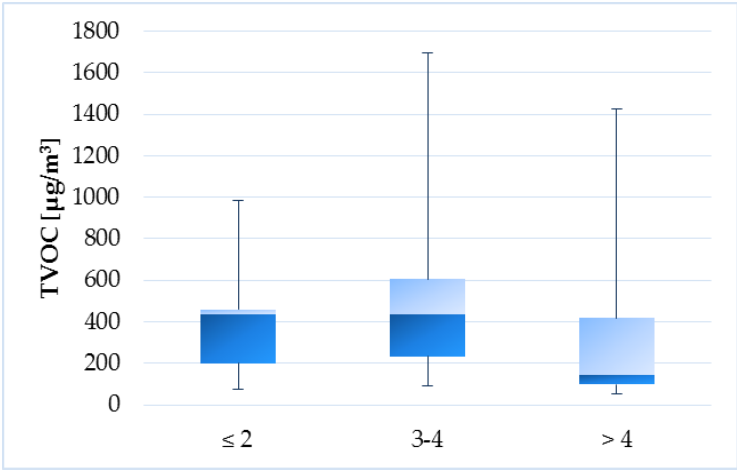
Figure 24. Boxplot of total medians—number of users.